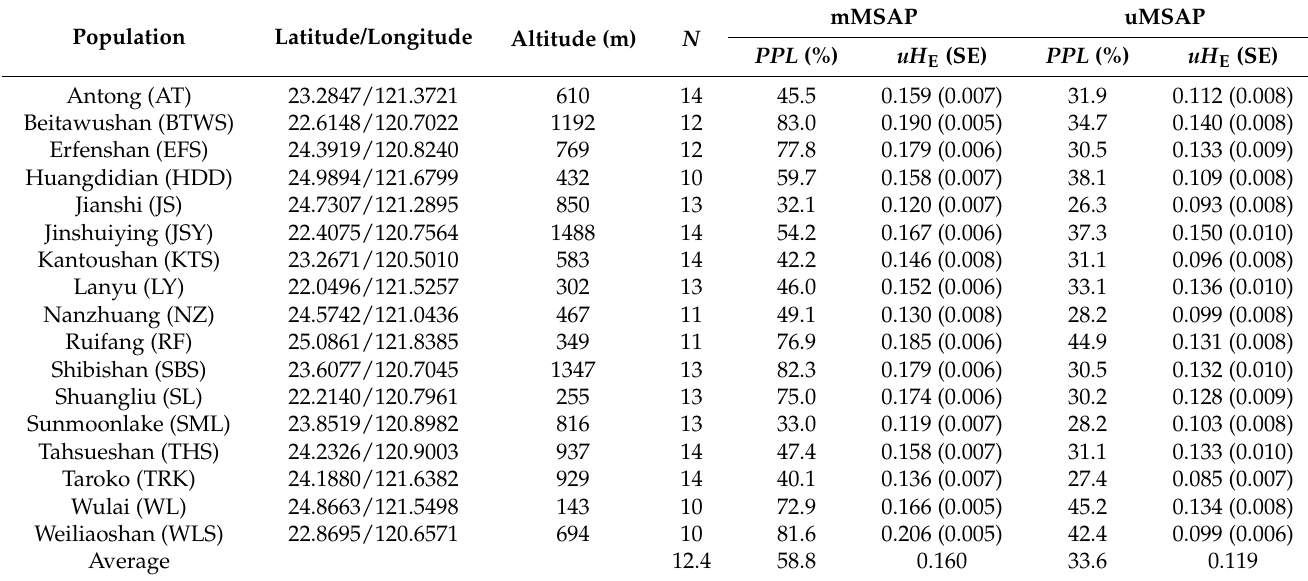
Table 1. Site properties and epigenetic parameters of the 17 sampled populations of Zingiber kawagoii estimated using total mMSAP and uMSAP